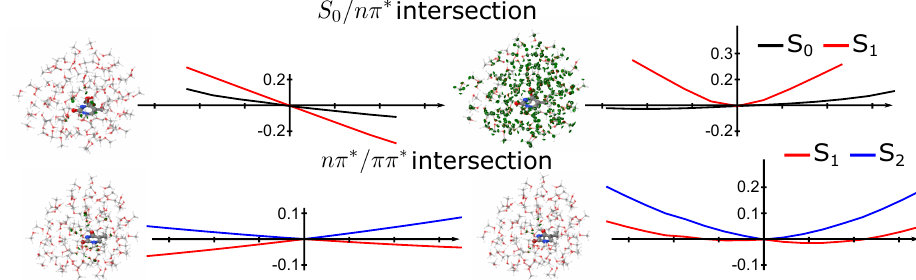
Figure 4. Topology of conical intersections of thymine in methanol. ( top ) S 0 / n π ∗ intersection and ( bottom ) n π ∗ / ππ ∗ intersection. Structures and graphs corresponds to the gradient difference vector and the PES along that coordinate ( left ) and non-adiabatic coupling vector ( right ). The contribution of the solvent on the branching plane vectors is shown in